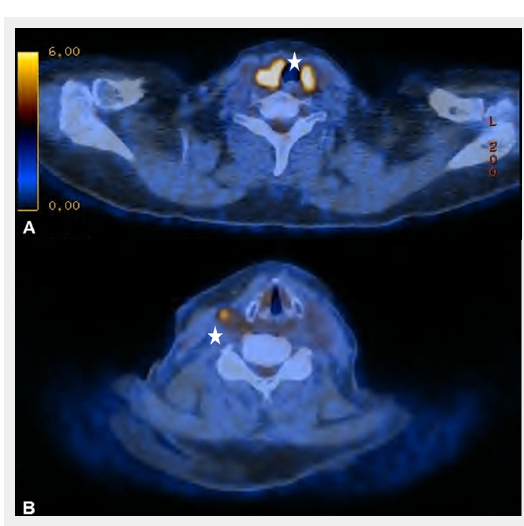
(A) Compensatory uptake in the left vocal cord in a 59-year old patient with known right unilateral vocal cord immobility due to a transglottic larynx carcinoma. (B) The corresponding T2-weighted magnetic resonance imaging examination helps to better delineate the immobile right vocal cord by providing superior soft-tissue contrast.